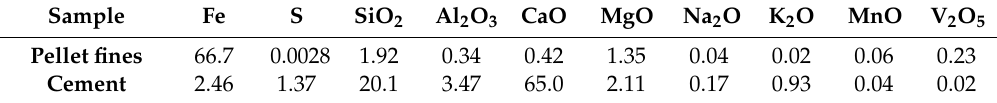
Table 3. Chemical composition of pellet fines and cement, (wt %).